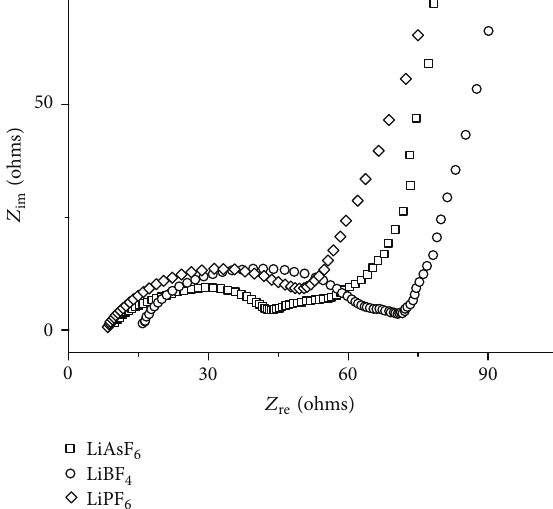
Figure 8: Nyquist plot of the composite electrodes with electrolyte salts.